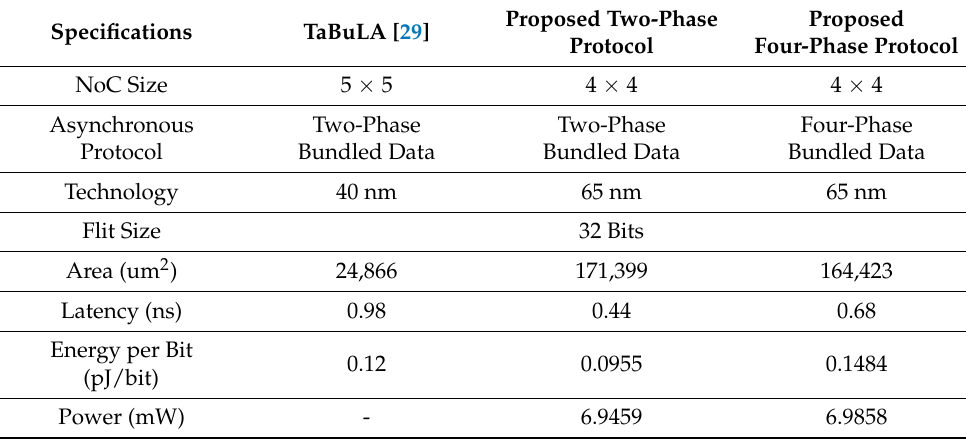
Table 1. Comparison with a recent asynchronous router